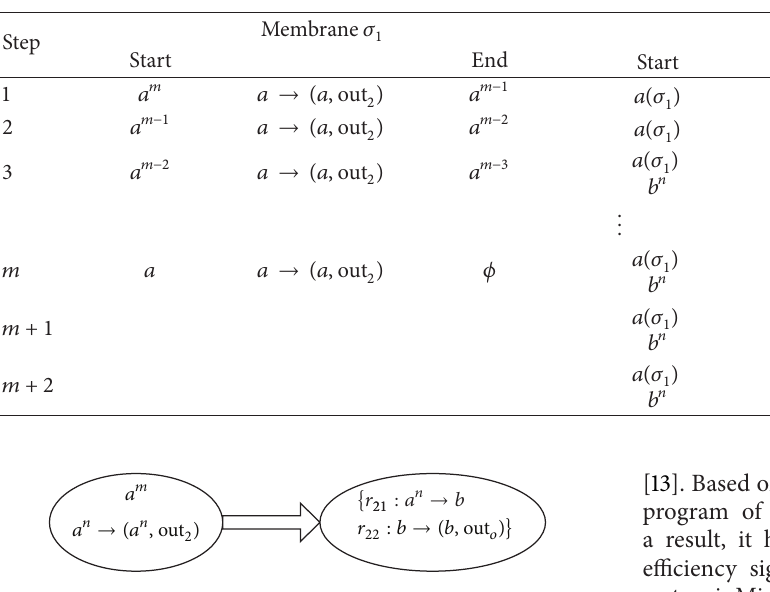
Table 1: The implementation of P chain system for multiplication.